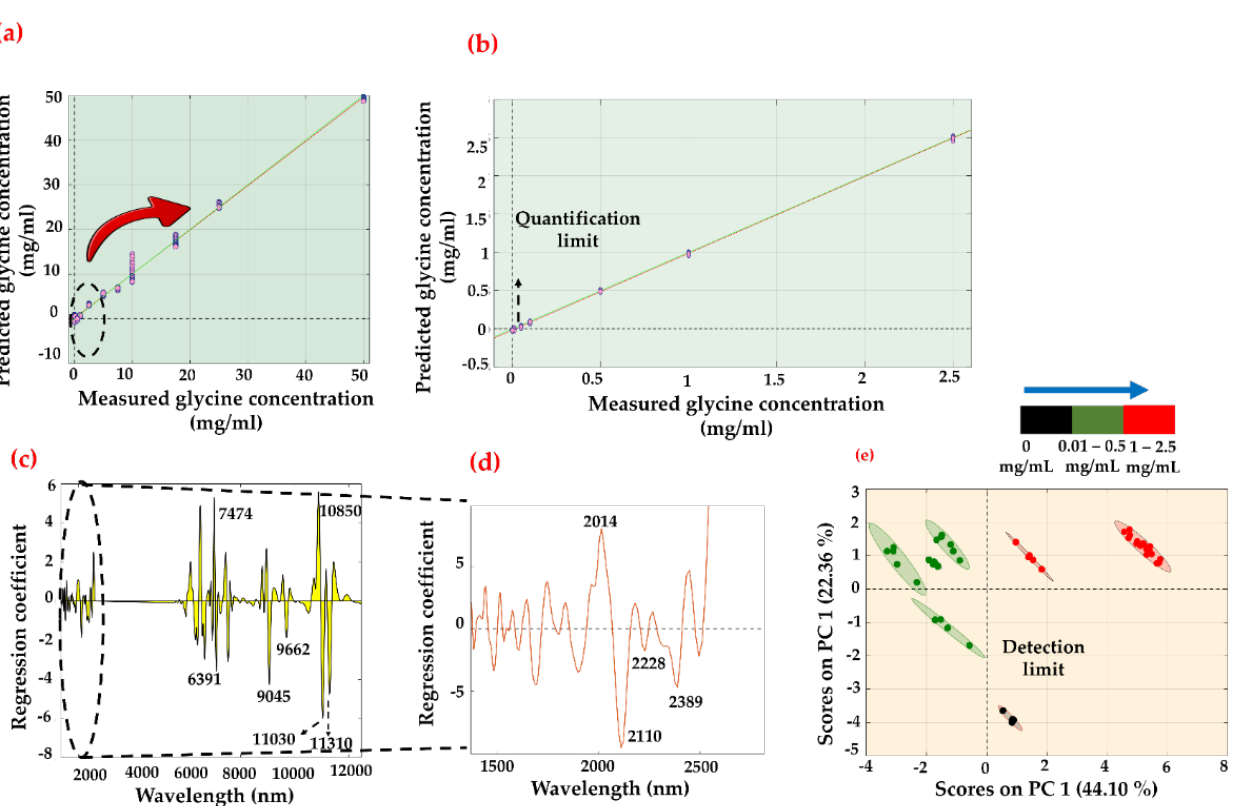
Figure 5. PCR predicted model of glycine-spiked serum samples. ( a ) Regression plot of entire range between 0 (control) and 50 mg/mL region. ( b ) Extrapolated and remodeled 0 – 2.5 mg/mL region. ( c ) Corresponding regression coefficient/vector over hetero-spectral region covering NIR (2500– 1350 nm) and MIR (1800–800 cm − 1 ). ( d ) Magnified view of regression vector over 2500–1350 nm and ( e ) scores plot between PC1 and